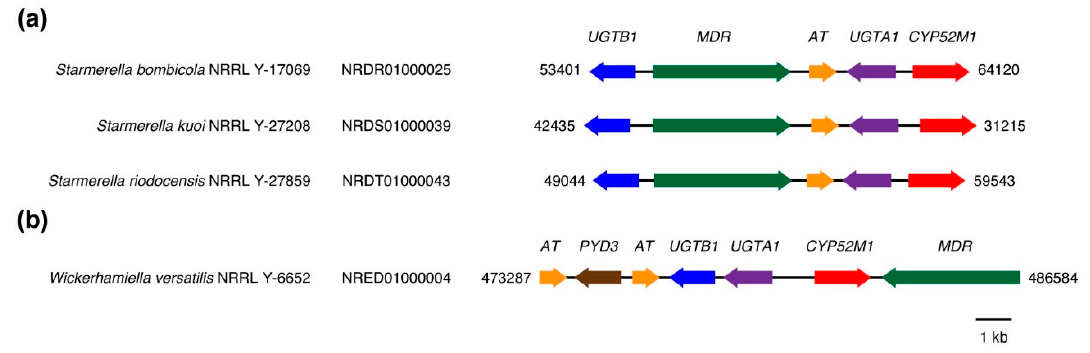
Figure 6. CYP-containing sophorolipid biosynthetic gene clusters in Starmerella and Wickerhamiella species. Genomic accession numbers and corresponding genomic sequence coordinates are indicated.